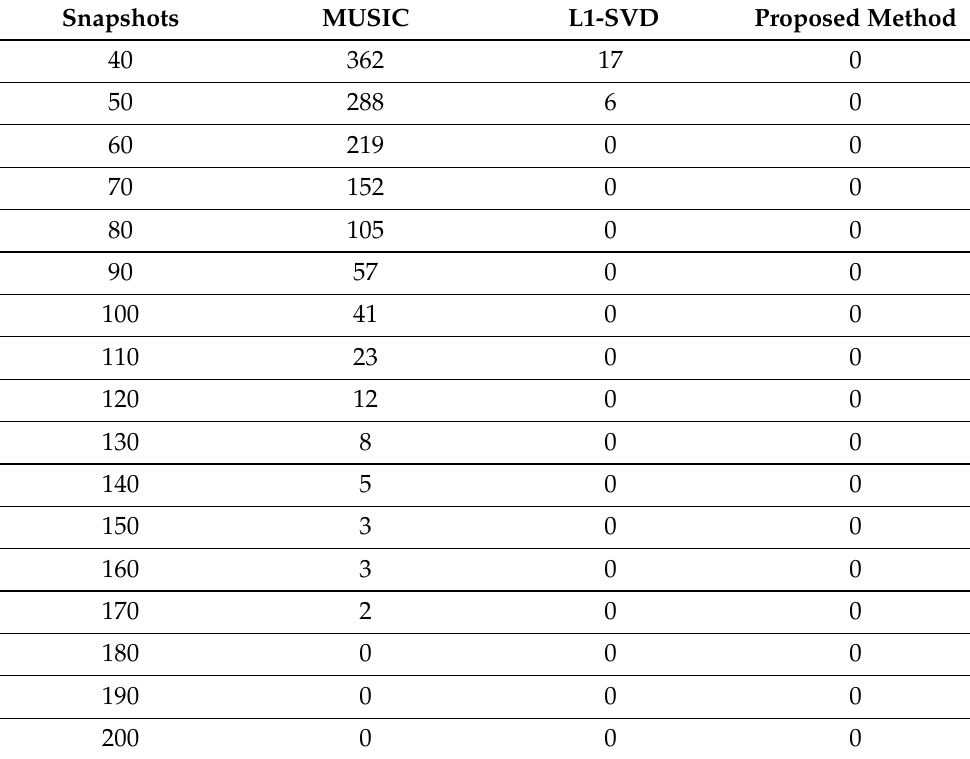
Figure 15. Variance in the estimated direction of the first emitter versus snapshots: Proposed Method, MUSIC Algorithm, and L1-SVD Algorithm, Emitters at 60 and 63 deg, SNR = 5 dB, 500 trials. Table 5. Number of Failures in 500 Trials with Respect to Number of Snapshots. SNR = 5 dB, Two emitters at 60 ◦ and 63 ◦